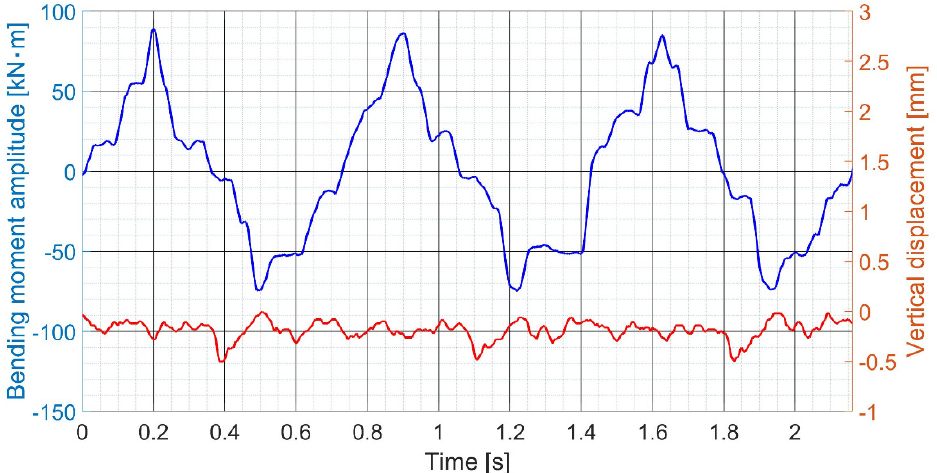
Figure 9. Example of a measured bending moment at the position of the strain gauge and the smoothed vertical displacement after processing at the NCR going straight ahead (filter type: moving average filter; span: 10).